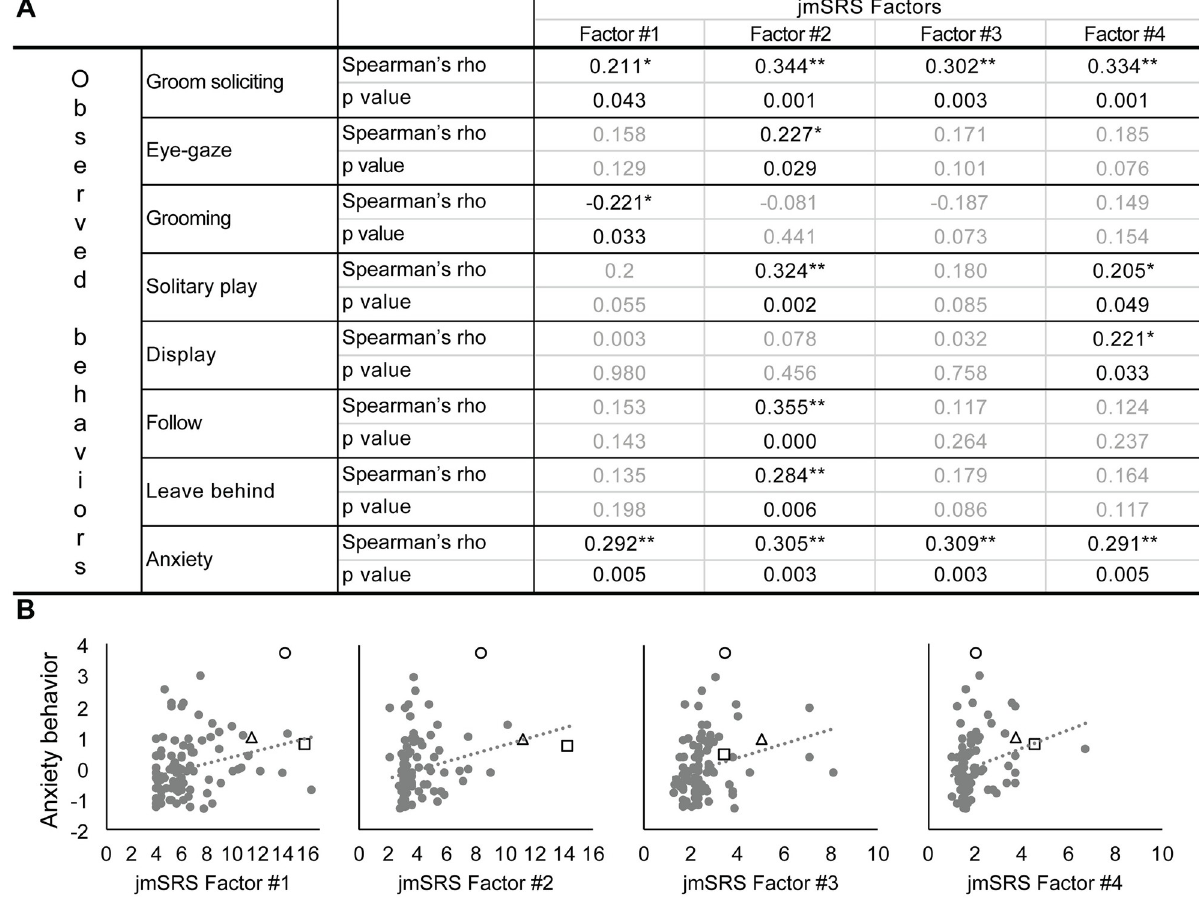
Fig 3. Correlations between the jmSRS factors (#1, #2, #3, #4) and behavior frequencies and durations collected with the ethogram. A) Correlation matrix, showing significant Spearman rho correlation coefficients between Ethogram behaviors and the jmSRS Factors. � p < 0.05, �� p < 0.01. B) Examples of regression plots representing individual Anxiety and jmSRS Factors score data. Y-axis represents Anxiety Z-scored frequency rates (counts/ hour; Anxiety frequency is calculated as a composite score -sum- of frequencies of scratching , yawning , body-shaking and self-directed behaviors such as self-grooming) ; X-axis represents the jmSRS factor scores (Factors #1–4) for each individual. The triangle, square and circle symbols represent the same 3 subjects in each graph, marked as outliers in the jmSRS and/or the anxiety behavioral scores.